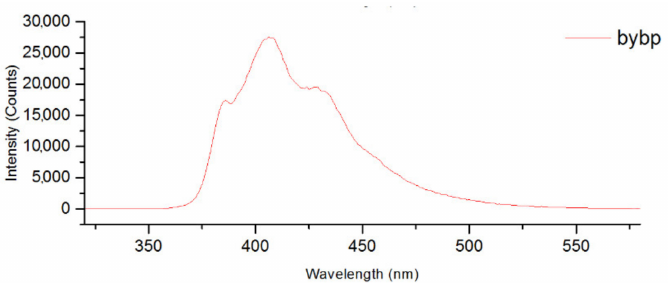
Figure 22. Emission spectrum of